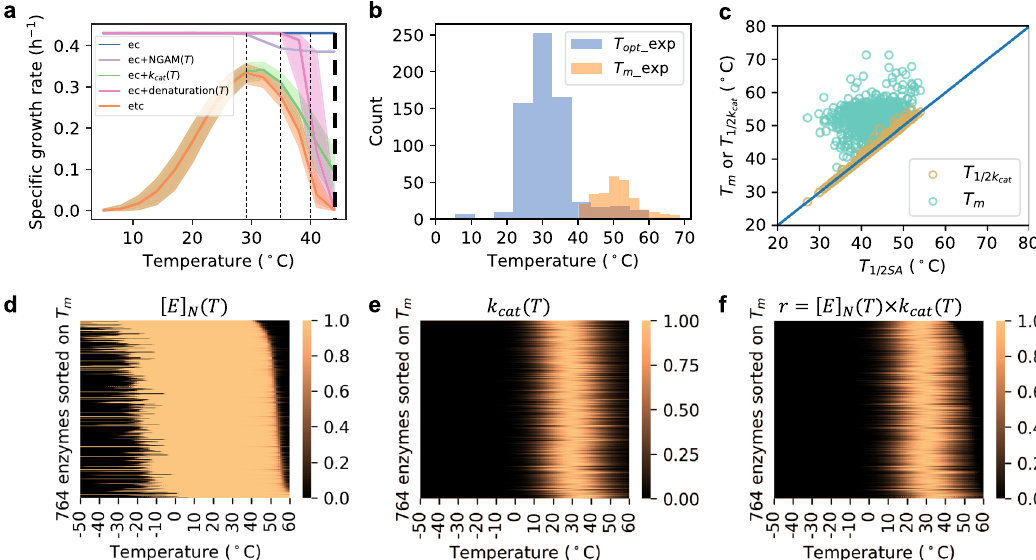
Fig. 3 Yeast growth rate is explained by temperature effects on its enzymes. a Illustration of how the temperature dependence of different processes combines to affect the growth rate. Fig. legend: ec — predictions with the enzyme constrained model; ec + NGAM( T ) — incorporates the temperature effects on nongrowth associated maintenance into the ec model (Supplementary Fig. 1); ec + k cat ( T ) — incorporates the temperature effects on enzyme k cat values into the ec model; ec + denaturation( T ) — incorporates the temperature effects on enzyme denaturation into the ec model; etc — enzyme and temperature constrained model that includes the temperature effects on NGAM, k cat and enzyme denaturation into ec model. The growth rate at each temperature point was simulated with all 100 Posterior etcGEMs. Lines indicate median values and shaded areas indicate regions between the 5th and 95th percentiles ( n = 100). b Comparison between distributions of experimentally measured enzyme T opt values ( n = 662) from BRENDA 35 and enzyme T m values ( n = 265) from Leuenberger et al. 7 in S. cerevisiae . c Comparison between T 1/2 SA , the temperature at which the speci fi c activity is 50% of its maximum, and T 1/2 k cat , the temperature at which the k cat value is 50% of its maximum, and T m in the Posterior models. d Probability of 764 enzymes in the native state. From top to bottom, the enzymes showed increased s . Each pixel represents one probability value of an enzyme at a speci fi c temperature. e Normalized k cat values of 764 enzymes at different temperatures. Each pixel represents one normalized value of an enzyme at a speci fi c temperature. f Normalized speci fi c activities of 764 enzymes at different temperatures. The values in ( f ) are products of ( d ) and ( e ). In d – f , the same ordering of enzymes is shown. Source data are provided as a Source Data fi